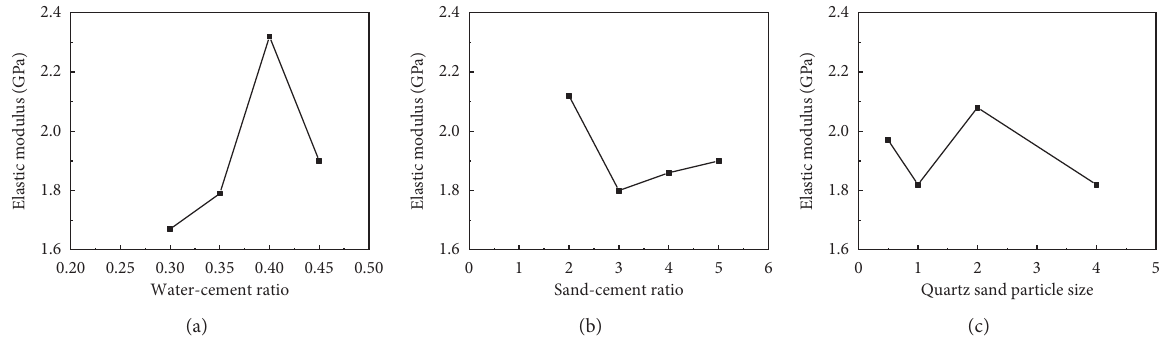
Figure 4: Sensitivity factor analysis of elastic modulus.